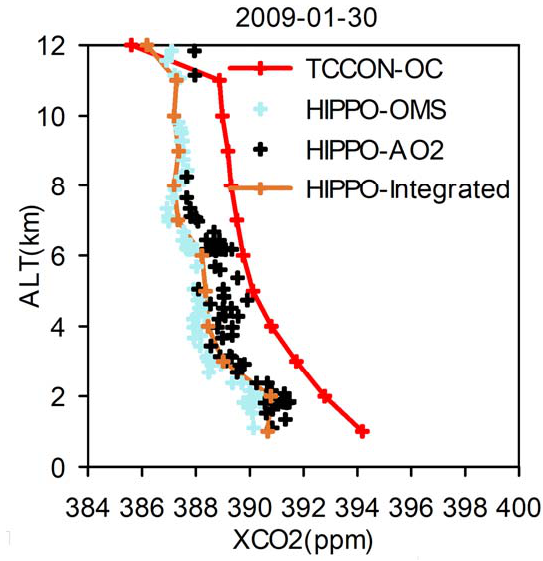
Figure 5. The integrated CO 2 profile by comparing the HIPPO aircraft profiles with the TCCON column data over Lamont (OC) on 30 January 2009. The red line shows the observed TCCON CO 2 profile. The light ‐ green and black crosses indicate the observation data of different instruments: HIPPP ‐ OMS and HIPPO ‐ AO2, respectively. The dark ‐ red line shows the integrated CO 2 profile.